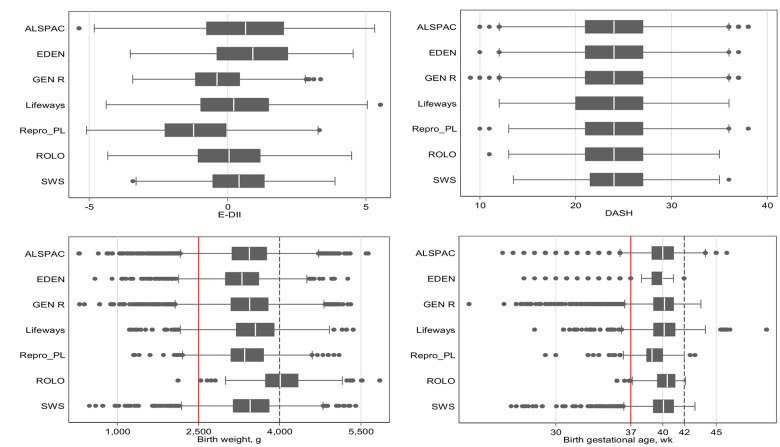
Boxplots of maternal pregnancy E-DII and DASH scores and offspring birth weight and gestational age at birth according to constituent studies.The red vertical solid and dotted lines represent clinical cutoffs for adverse birth outcomes. DASH, Dietary Approaches to Stop Hypertension; E-DII, energy-adjusted Dietary Inflammatory Index.